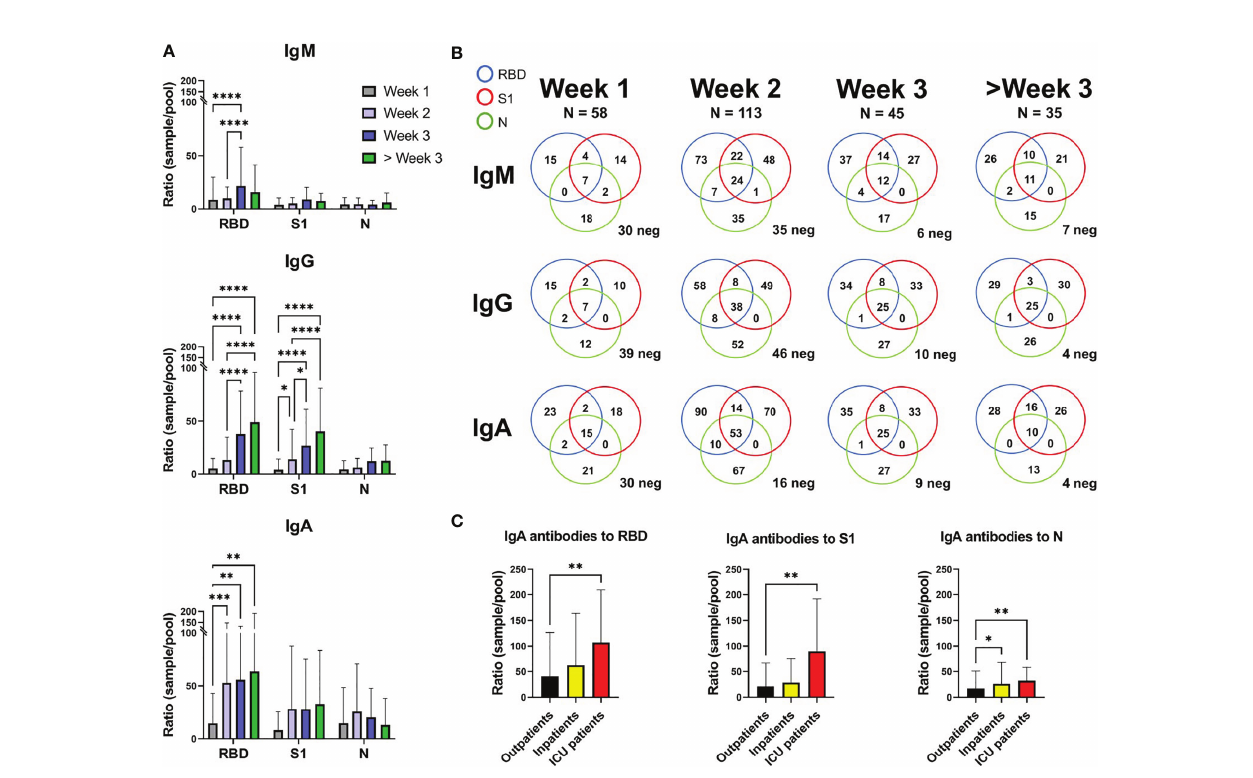
FIGURE 2 | SARS-CoV-2 speci fi c antibody levels against the RBD, S1, and N proteins in 221 COVID-19 patients. (A) Depicting the mean and standard deviation in sample/pool ratio of SARS-CoV-2 antibody levels for IgM, IgG, and IgA for weeks 1, 2, 3 and over 3 weeks. (B) Venn diagram showing the number of patients with a ratio >4 for IgM, IgG, and IgA against the RBD, S1 and N proteins. Patients below the cut-off value of 4 in ratio against all proteins are depicted as neg in the bottom right corner of each diagram. 35 out of the 251 samples were below 4 for all the proteins, for the three antibody isotypes. (C) The IgA sample/pool ratio in COVID-19 outpatients (n=168), inpatients (n=40), and ICU patients (n=13). *, **, *** and **** correspond to p=<0.05, p=<0.01, p<0.001 and p=0.0001,